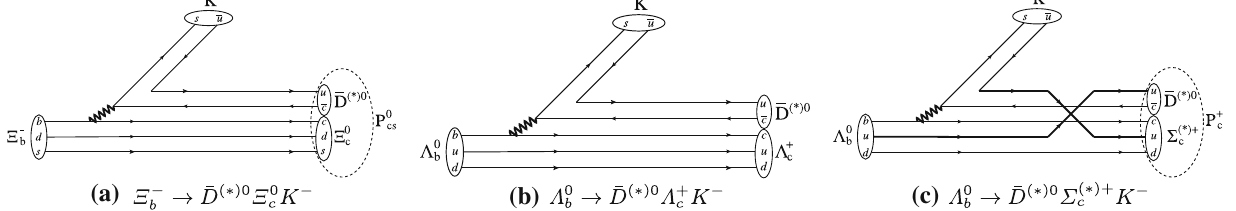
Fig. 3 Possible production mechanisms of the P + c and P 0 cs states in Λ 0